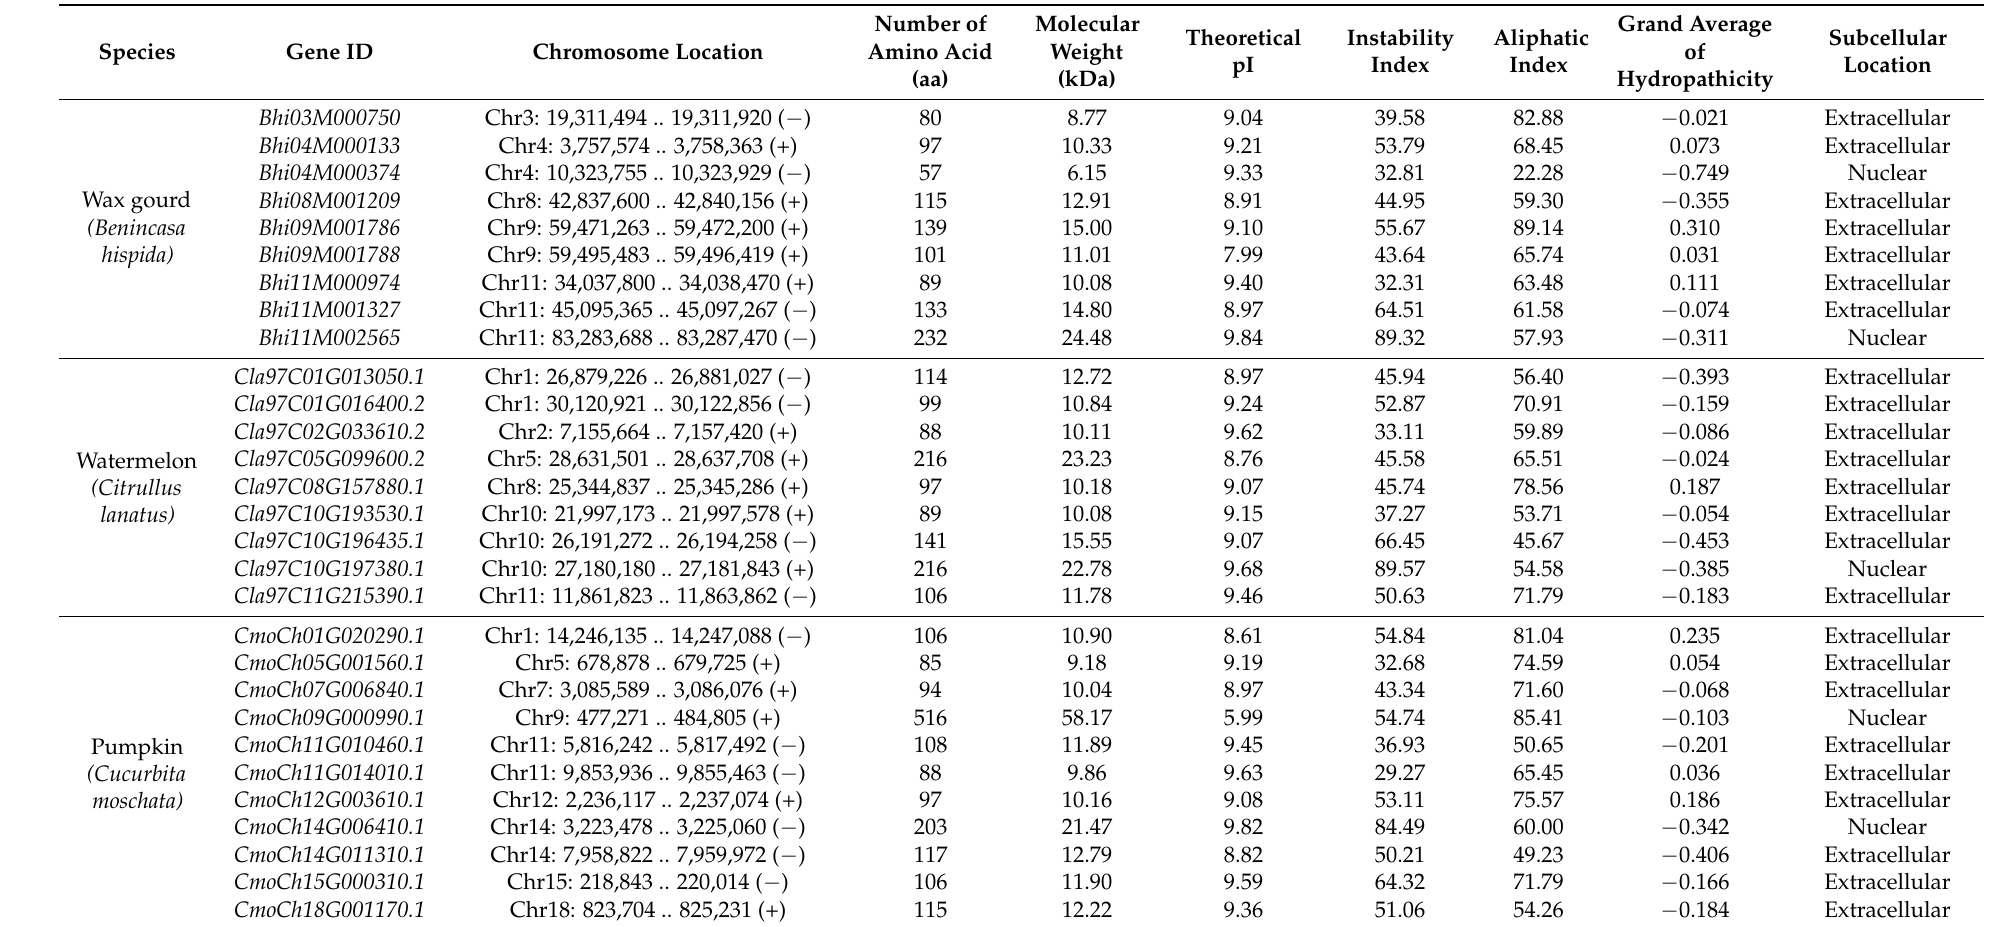
Table 1. The physiochemical characteristics of GASA family genes in 10 Cucurbitaceae